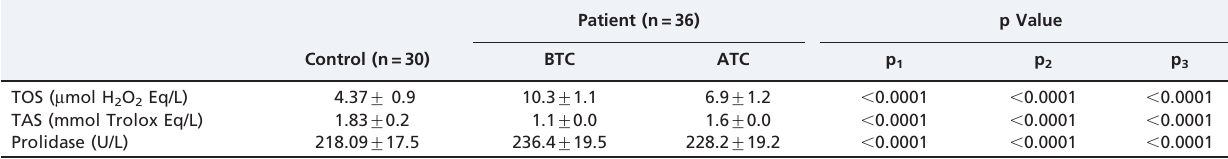
Table 2 - Mean serum total antioxidant status, total oxidant status and prolidase enzyme activities of the patients (before and after tadalafil citrate) and control